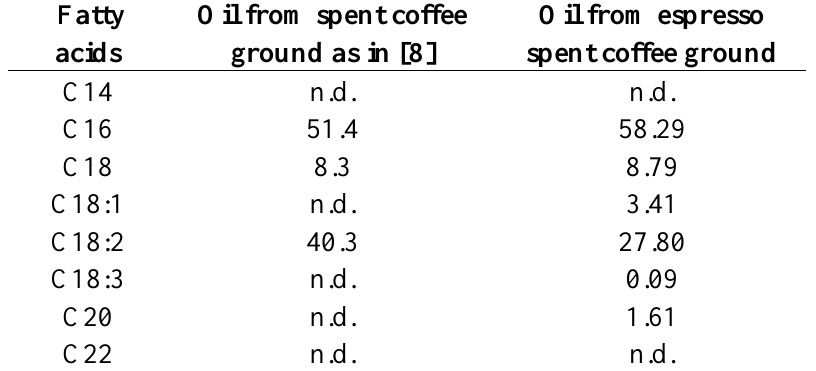
Table 3. Composition of the oil from espresso spent coffee ground in terms of fatty acids and compared to the oil used in the work of Kondamundi et al .